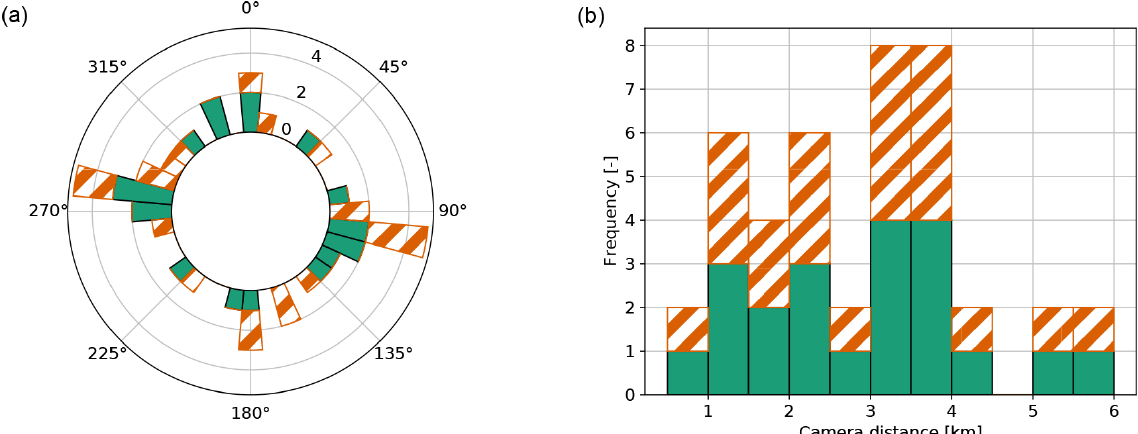
Figure 2. Frequency distribution of the bearing angles of the axes of the ASI pairs in the set of available ASI pairs (over north; a ) and frequency distribution of available camera distances (b) resulting when arranging the seven ASIs in the urban area into 42 ASI pairs (from each two-ASI tuple, two different ASI pairs result by switching the main camera). The counts of ASI pairs with the switched main camera are marked with candy-striped orange.